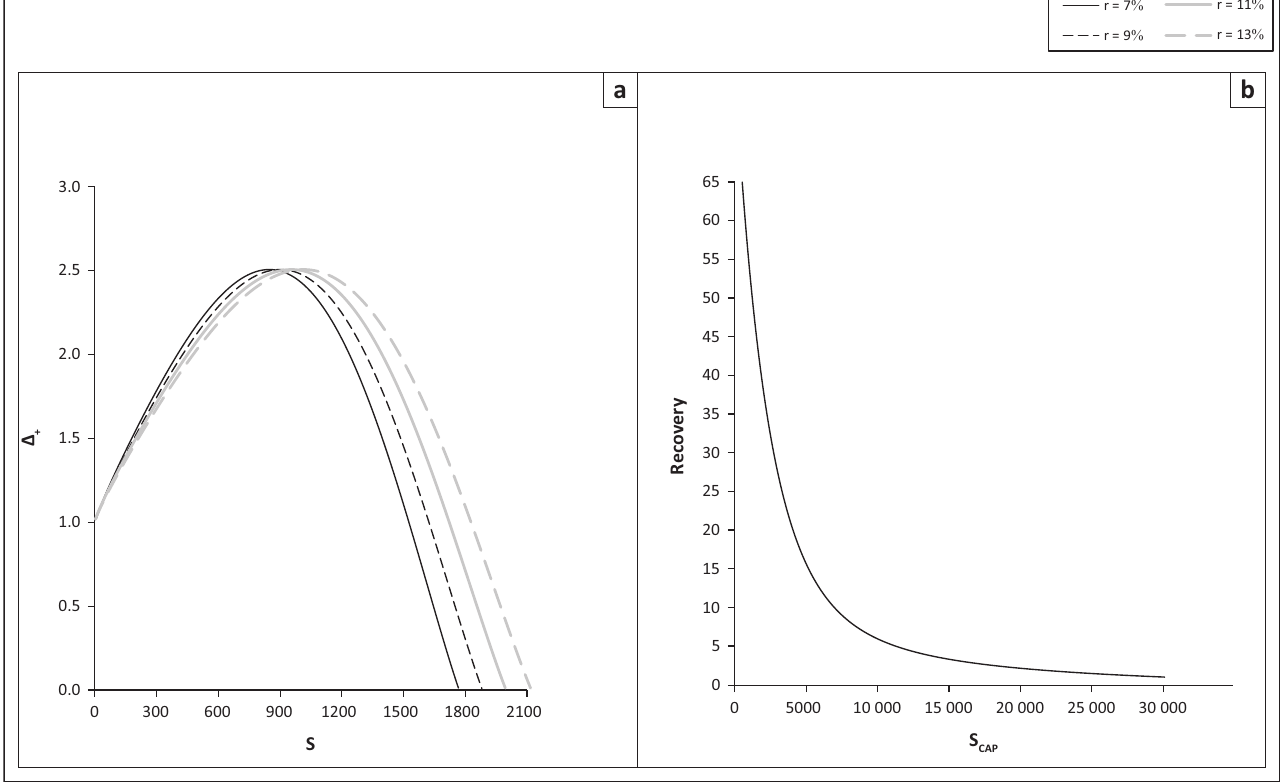
FIGURE 10: Impact of (a) the risk-free rate on the inflator as a function of S and (b) the bond recovery rate on S